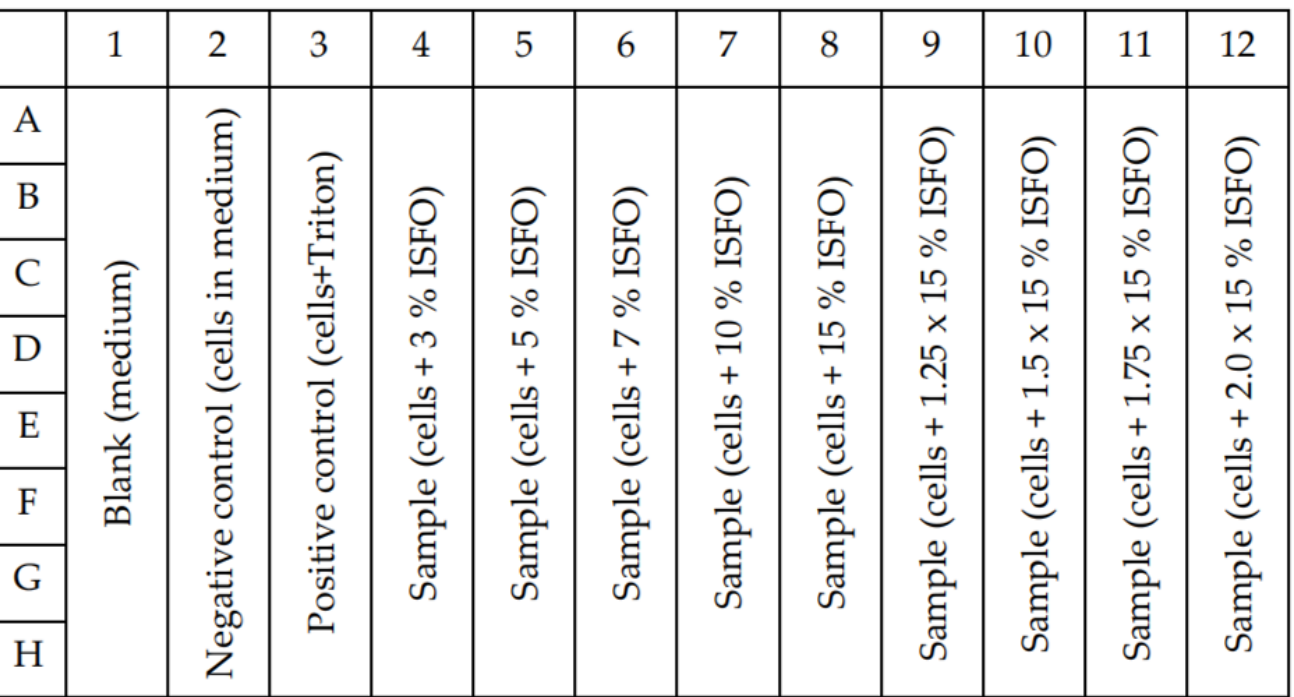
Figure A2. The cell toxicity testing setup. On a 96 well plate, each column is dedicated to a different test solution. Column 1 is filled with pure cell medium as a blank, column 2 contains cells in medium as a negative control, and column 3 contains cells in medium stressed by a 0.05% Triton TM X 100 solution. Columns 4–8 contain cells in medium treated with test solutions corresponding to increasing 12-HSA-concentrations (3–15%). Columns 9–12 are treated with a corresponding 12-HSA-concentration to column 8 but at higher v / v